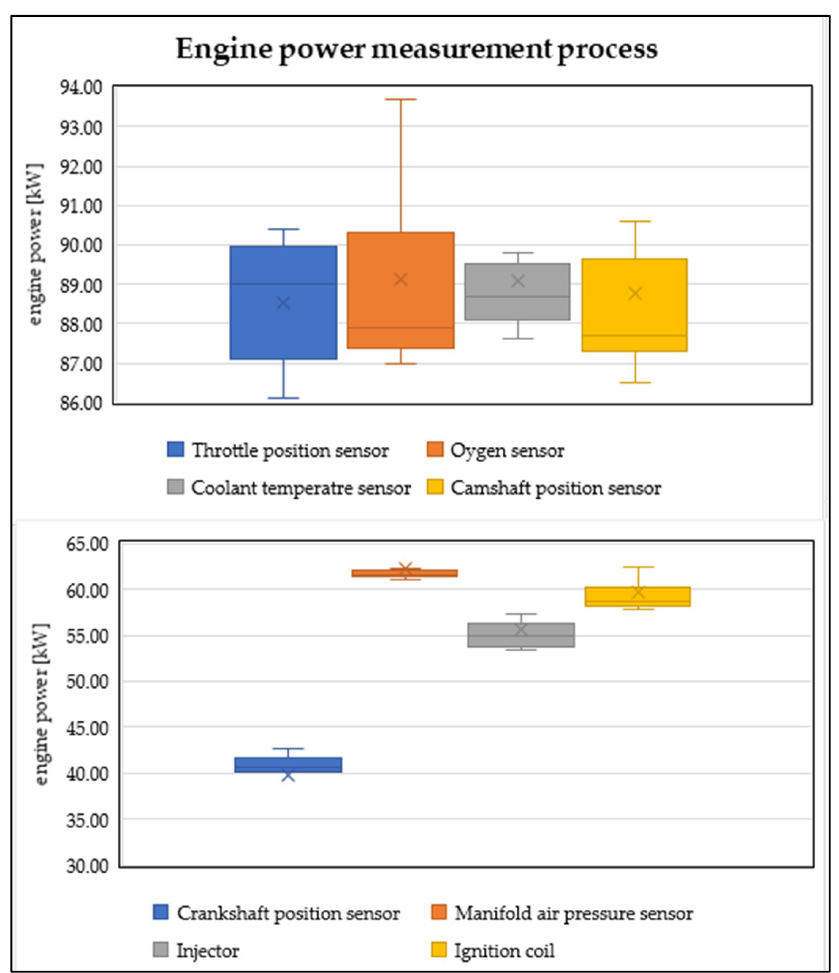
Figure 2. Course of power decrease in individual measurements (author).